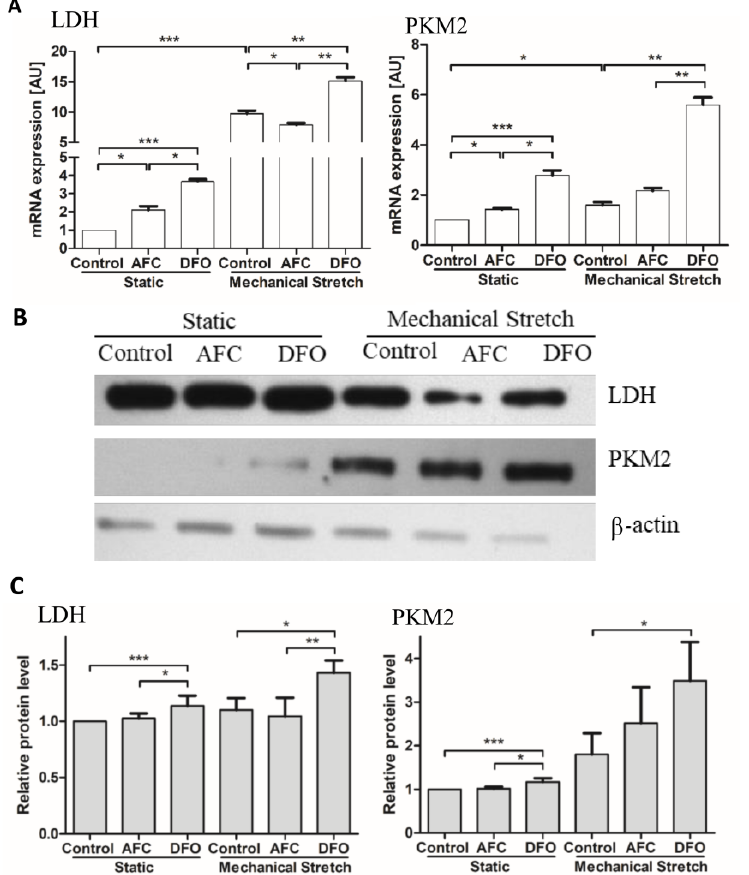
Figure 3. Expression of enzymes of non-oxidative metabolism in HCM cells cultured in static conditions or upon mechanical stretch with concomitant optimal, increased or reduced iron availability. mRNA expression levels of LDHA and PKM2: ( A ) representative immunoblot of LDH and PKM2 and β -actin as a loading control; ( B ) summary data showing relative protein expression in cell lysates standardized to β -actin. ( C ) Data are presented as the mean ± standard deviation obtained from three separate experiments. * p < 0.05; ** p < 0.01; *** p < 0.001. AU, arbitrary units; LDHA, lactate dehydrogenase A; PKM2, pyruvate kinase; LDH, lactate dehydrogenase; AFC, ammonium ferric citrate; DFO, deferroxamine.